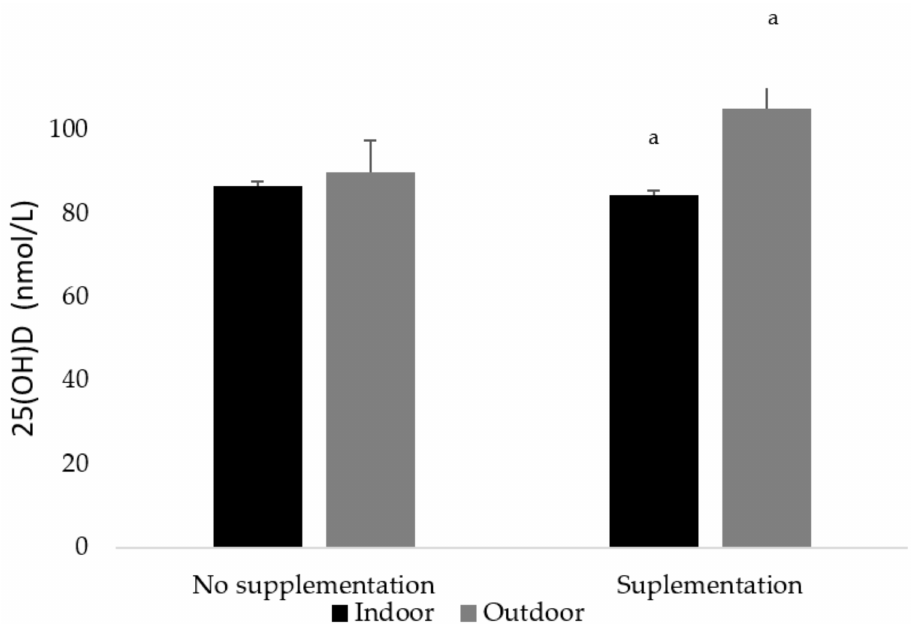
Figure 5. 25(OH)D concentrations (nmol/L) according to training place and supplementation. a Significant differences were set up for outdoor supplemented players ( p <